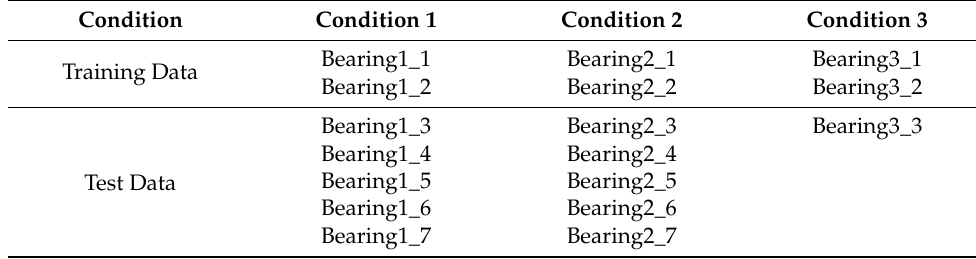
Table 3. IEEE PHM2012